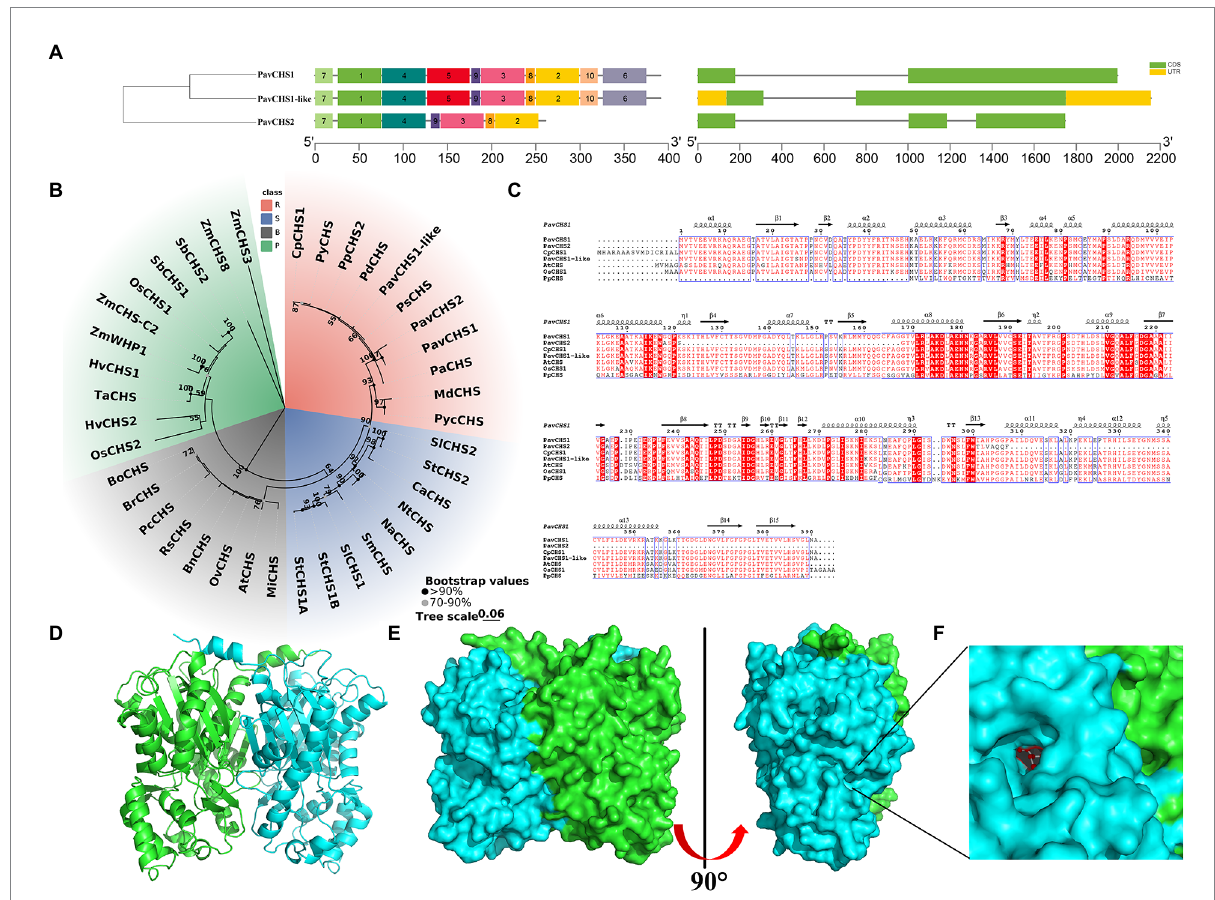
FIGURE 1 Characterization of CHS in sweet cherries. (A) Conserved motifs (left) and gene structures (right) of PavCHSs, conserved motifs and gene structures are represented by square boxes with different colors, and the black lines on the right represent introns. (B) The evolutionary relationship of CHS genes in four types of plants, different types of plants are represented by different colored branches on the phylogenetic tree. R, S, B, and P represent Rosaceae, Solanaceae, Brassicaceae, and Poaceae, respectively. (C) Multiple sequence alignment of CHS genes in sweet cherry, Chinese cherry, Arabidopsis thaliana , rice, and peach; red background indicates complete agreement, above the sequence is the predicted protein secondary structure. (D) Protein tertiary structure of PavCHS1. (E) The surface structure of PavCHS1 protein. (F) The possible active site